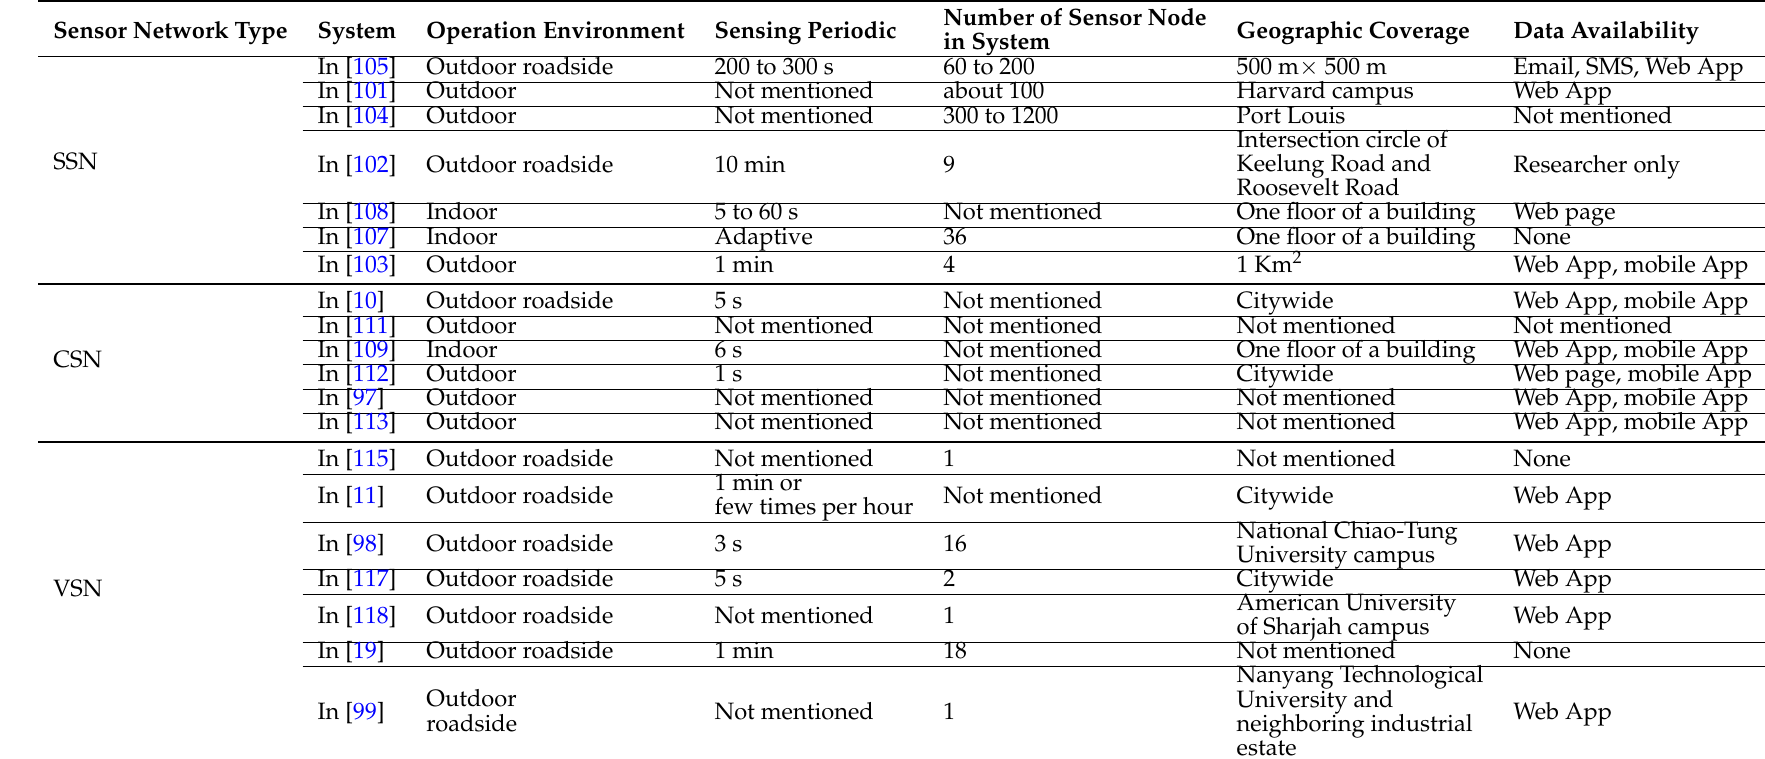
Table 10. Summary information of the 20 systems in literature works (Part